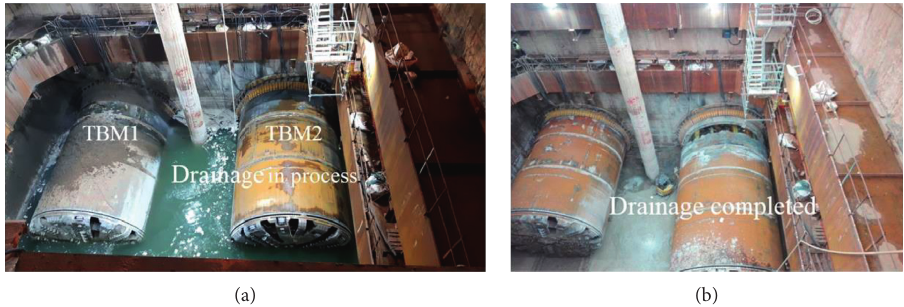
Figure 16: Completion of shield recovery: (a) drainage of the shaft and (b) recovery of the tail of the shield from the